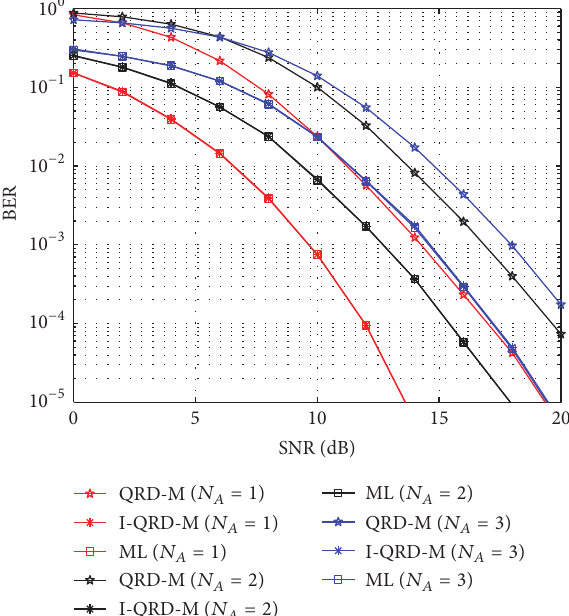
Figure 6: BER comparison for GSM scheme versus SNR for different number of active antennas 𝑁 𝐴 with 𝑁 𝑡 = 4 , 𝑁 𝑟 = 4 , and 𝑀 = 5 for